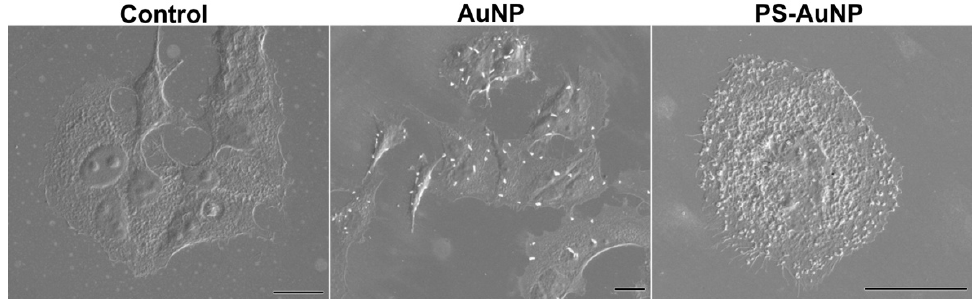
Figure 9. PS-AuNPs induce morphological changes consistent with apoptosis in MDA-MB-231 cells. Scanning electron microscopy of MDA-MB-213 cells challenged with either PBS (control—left panel), AuNP (central panel), or PS-AuNP (Right Panel). Scale bar equivalent to 20 µ